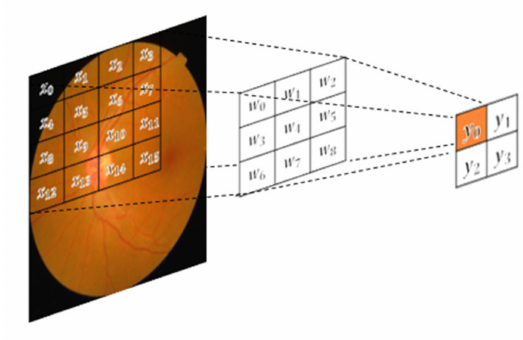
Figure 4. Convolution